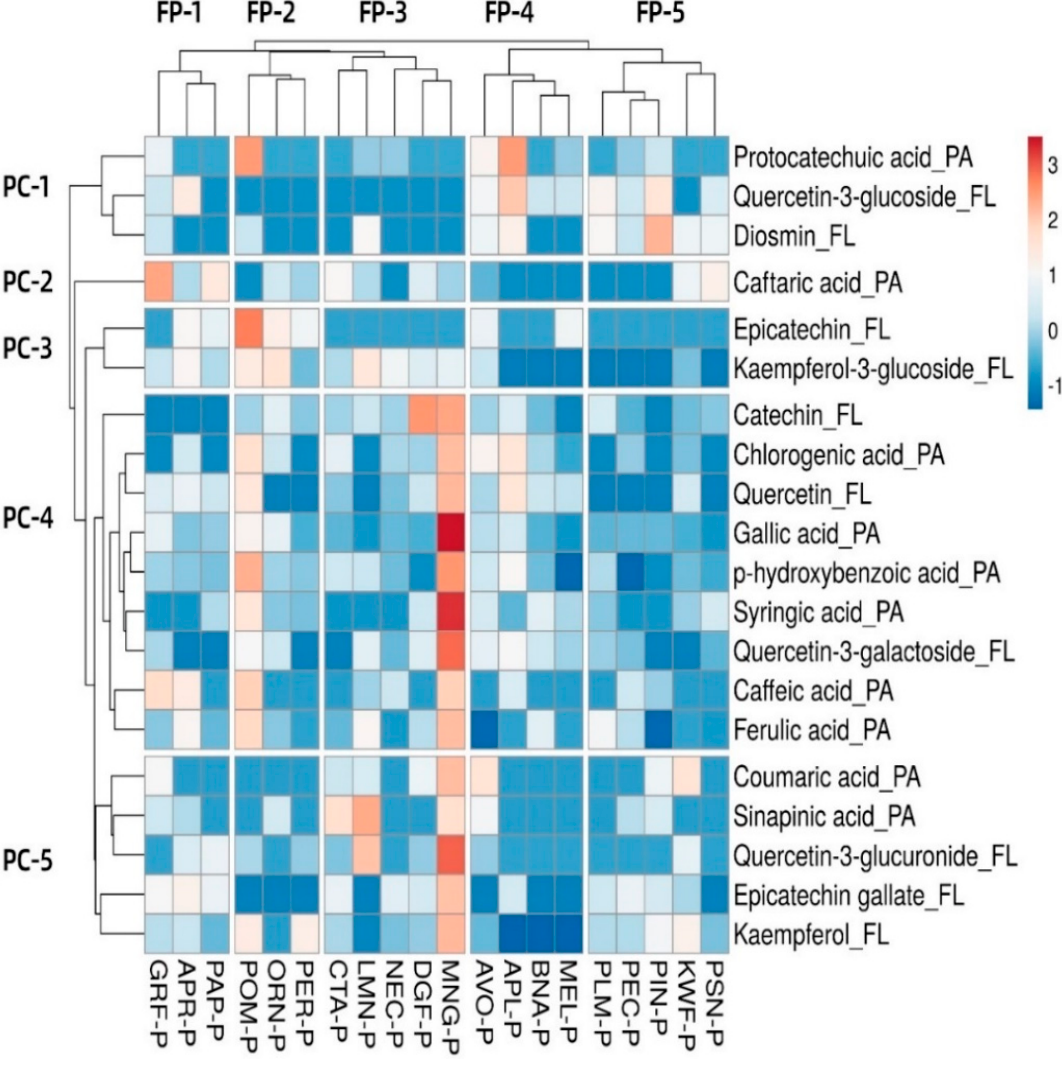
Figure 4. Heatmap showing phenolic compounds’ distribution and concentration among twenty fruit peel samples. Red boxes mean concentrations are higher among di ff erent fruit peel samples. Blue boxes mean lower concentrations. PA: phenolic acids; FL: flavonoids; FP 1-5: fruit peel clusters 1; PC 1-5: phenolic compound clusters. Fruit peel samples were mentioned in abbreviations. Apple peel “APL-P”, Apricot peel “APR-P”, Avocado peel “AVO-P”, Banana peel “BNA-P”, Custard apple peel “CTA-P”, Dragon fruit peel “DGF-P”, Grapefruit peel “GRF-P”, kiwifruit peel “KWF-P”, Lime peel